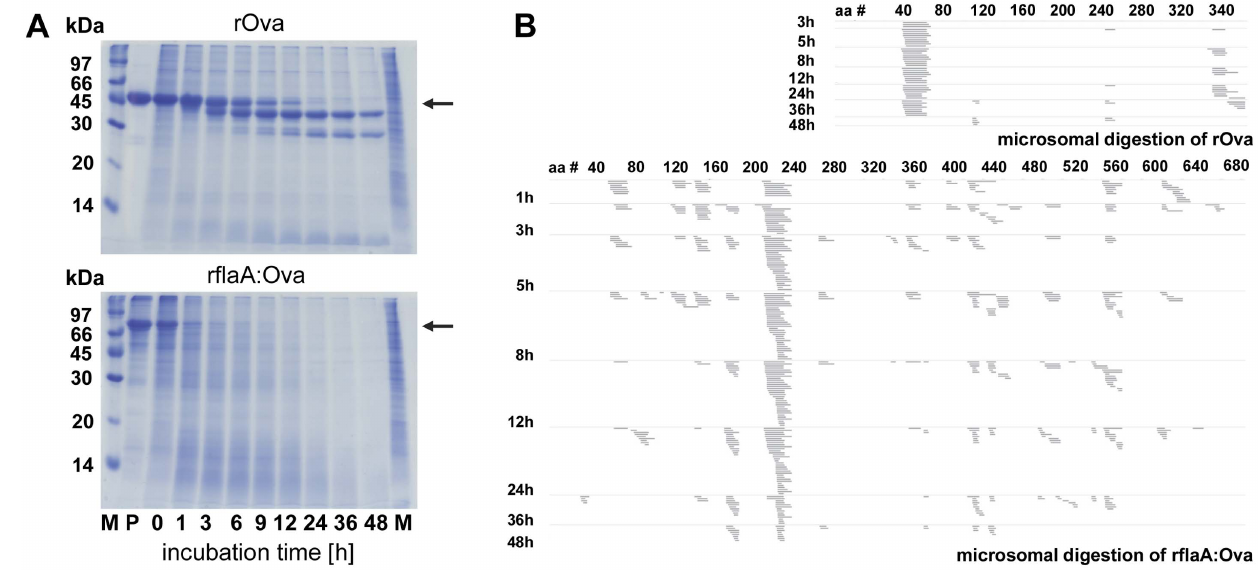
Figure 4. rflaA:Ova is differently processed in mDC-derived microsomes. Microsomes were isolated from unstimulated BALB/c mDC and used for digestion of rOva and rflaA:Ova ( A + B ). Protein amounts equimolar to 5 m g rOva (5 m g rOva, 8.5 m g rflaA:Ova) were digested for each indicated time point. Subsequently, half of the samples were analyzed by SDS-PAGE ( A ) and for the resulting peptide pattern by mass spectrometry B). M=molecular weight marker, arrow indicates the MW of the digested target protein. M molecular weight marker, P protein without microsomes, M microsomes without protein, aa # amino acid residue number.